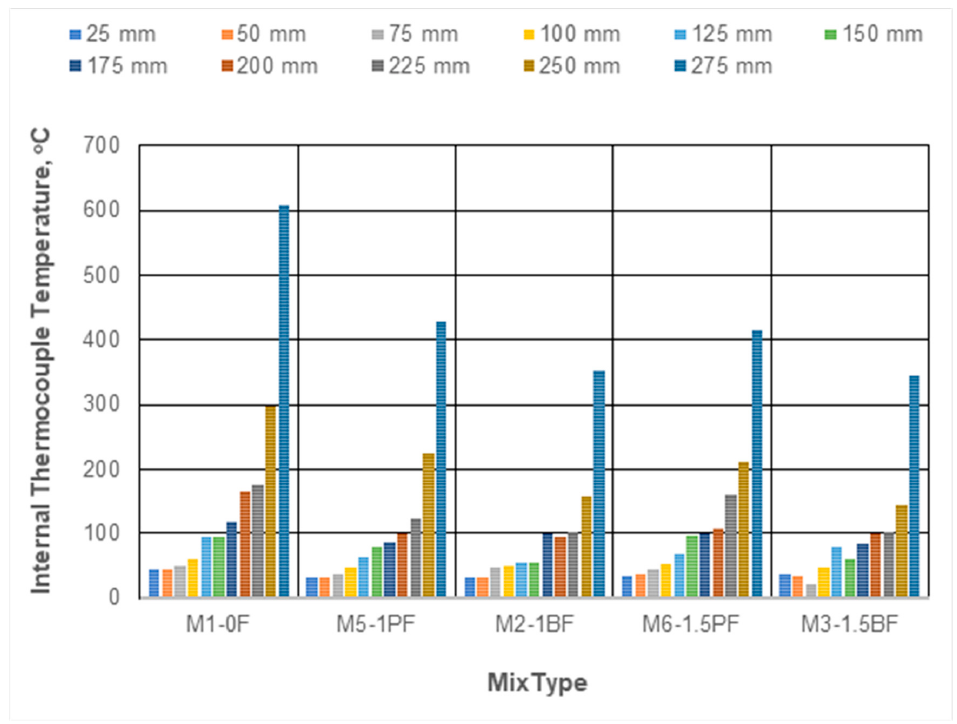
Figure 9. Temperature measurements of internal thermocouples installed at different depth of the slab